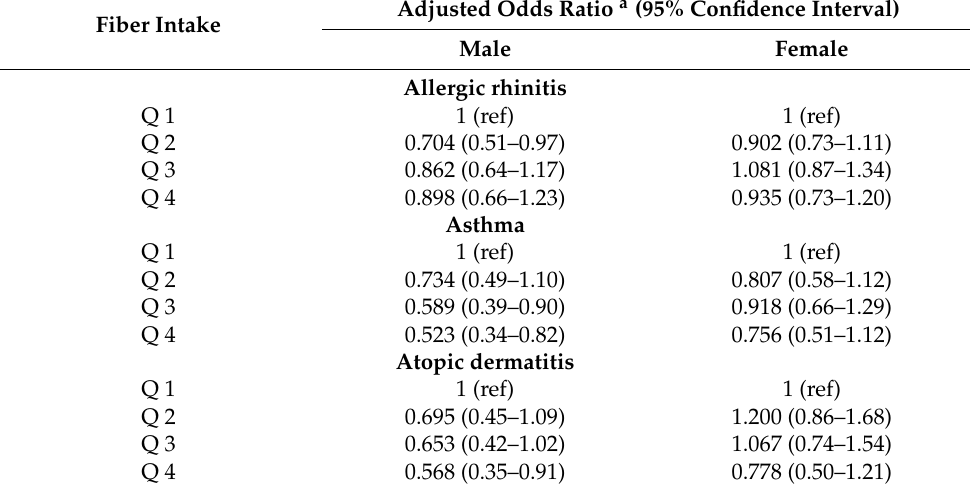
Table 3. Multivariate logistic regression analysis of the association between fiber intake and the prevalence of allergic diseases according to